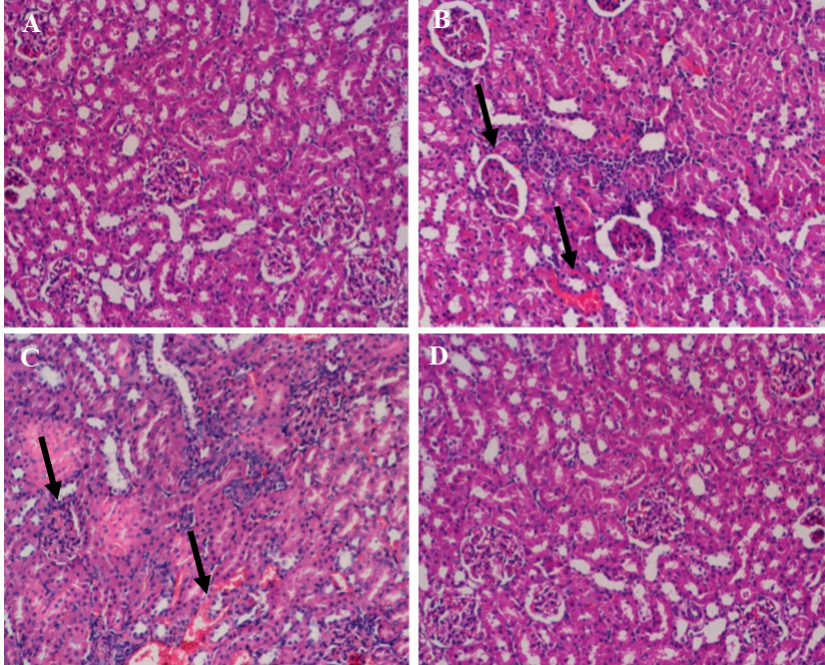
Figure 4. ( A – D ) Photomicrograph of rat kidney tissue section. ( A ) Normal histology of the kidney tissue in group I (control) shows the normal architecture of the glomerulus and tubules (H&E ×200). ( B ) Group II (Cisplatin) showing, with the black arrow, extensive degeneration, acute tubular necrosis, hyaline casts, interstitial edema, and inflammatory cell infiltration (H&E ×200). ( C ) Group III(test) showed improved histopathologic resembling group II(H&E ×200). ( D ) Group IV(per se) shows normal architecture (H&E ×200).